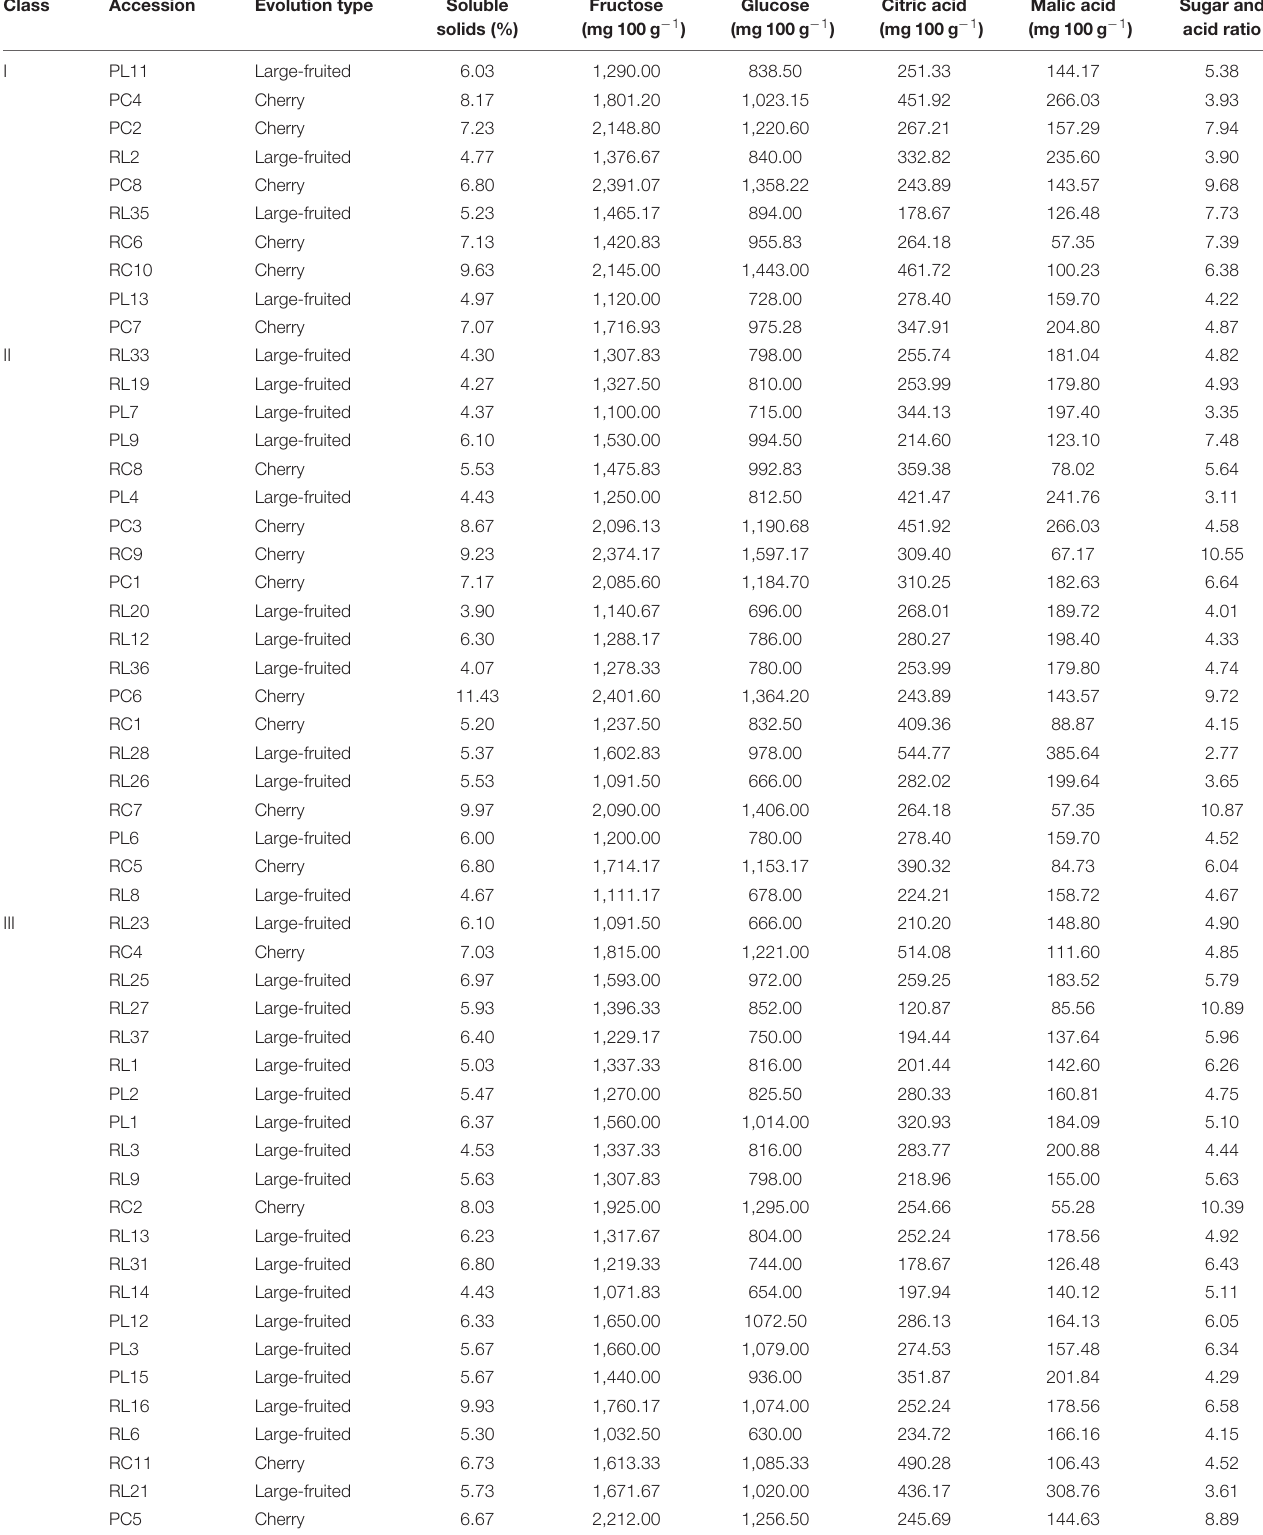
TABLE 1 | Concentrations of taste compounds of mature tomato